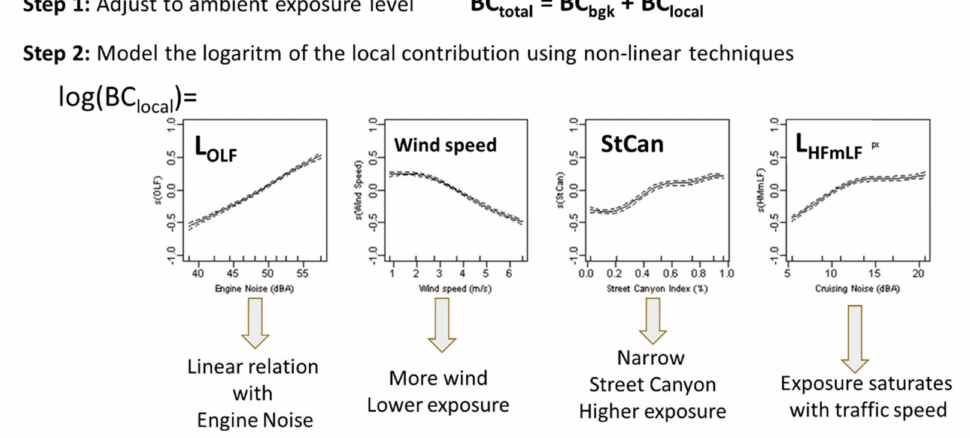
Figure 2. The cyclist black carbon prediction model is based on the engine noise, wind speed, cruising noise and street canyon